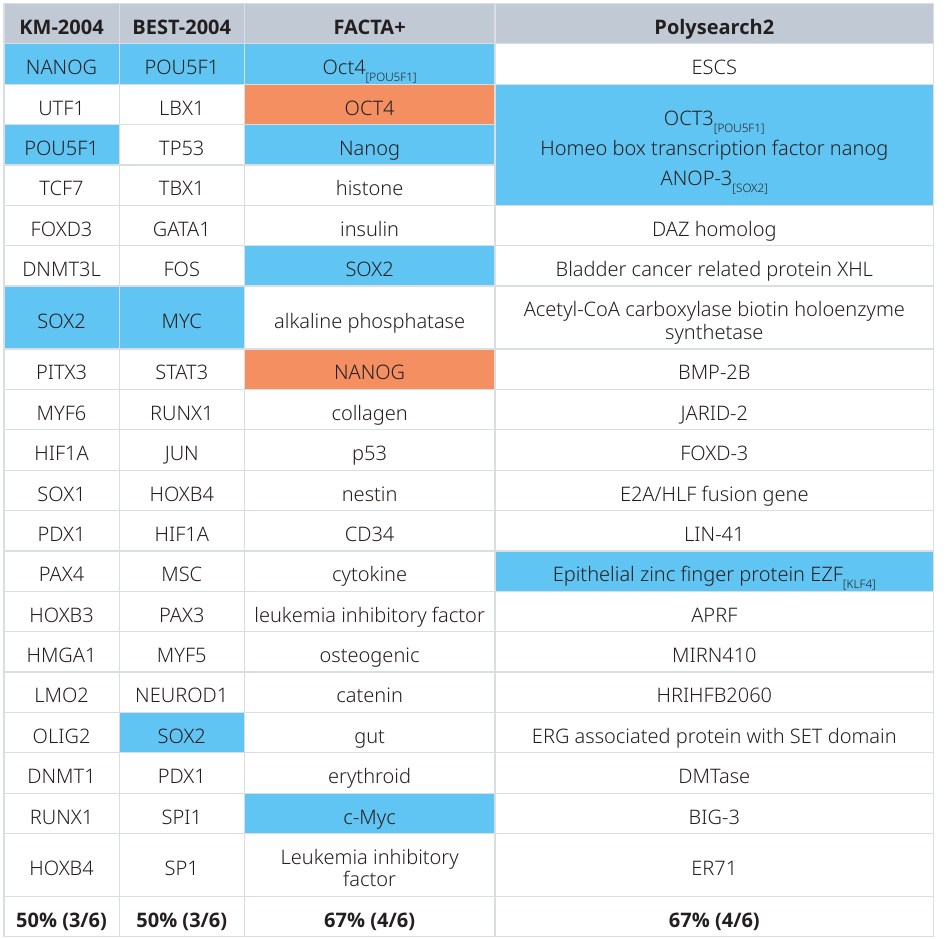
Table 1. iPS cell transcription factor search. Landmark factors are highlighted in blue (duplicates in orange) and the bottom row shows Recall@20. All methods find a sufficient set of factors (POU5F1 and SOX2). Note that KinderMiner and BEST have been censored to articles published through 2004, whereas the other methods have no such censoring, giving them the advantage of access to the landmark papers and